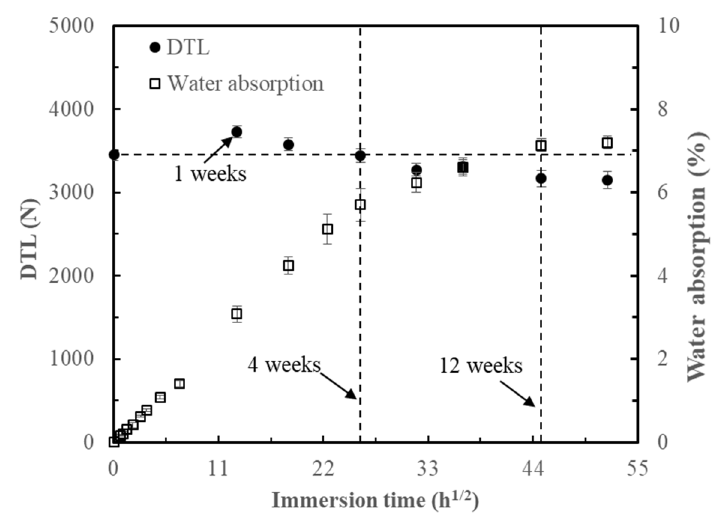
Figure 10. Variations of DTL and water absorption with the square root of immersion time.